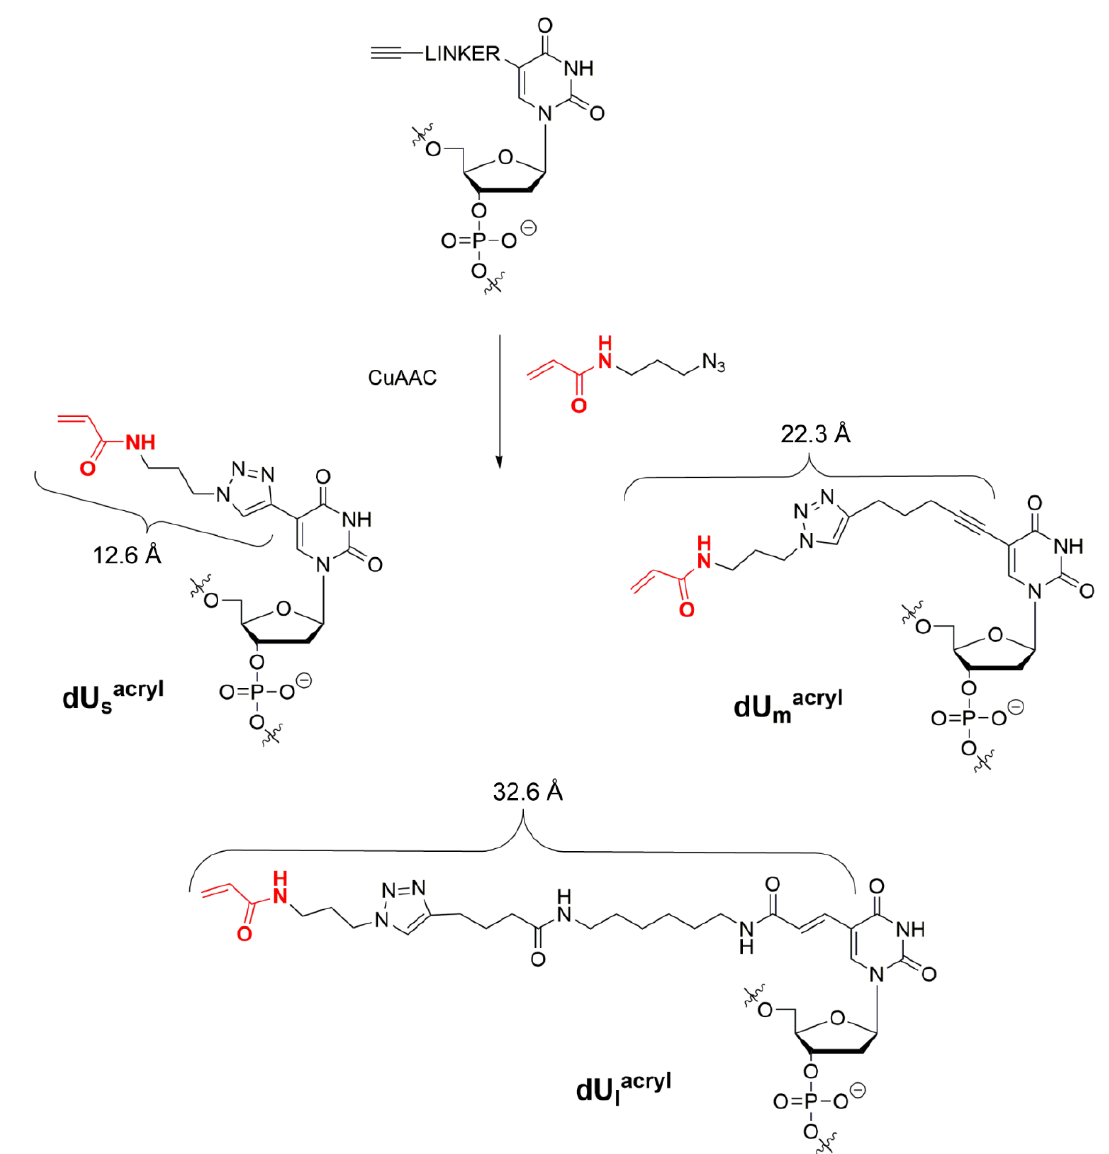
Figure 3. The scheme of the synthesis of oligonucleotides carrying the acrylamide group from ethynyl-containing oligonucleotides.